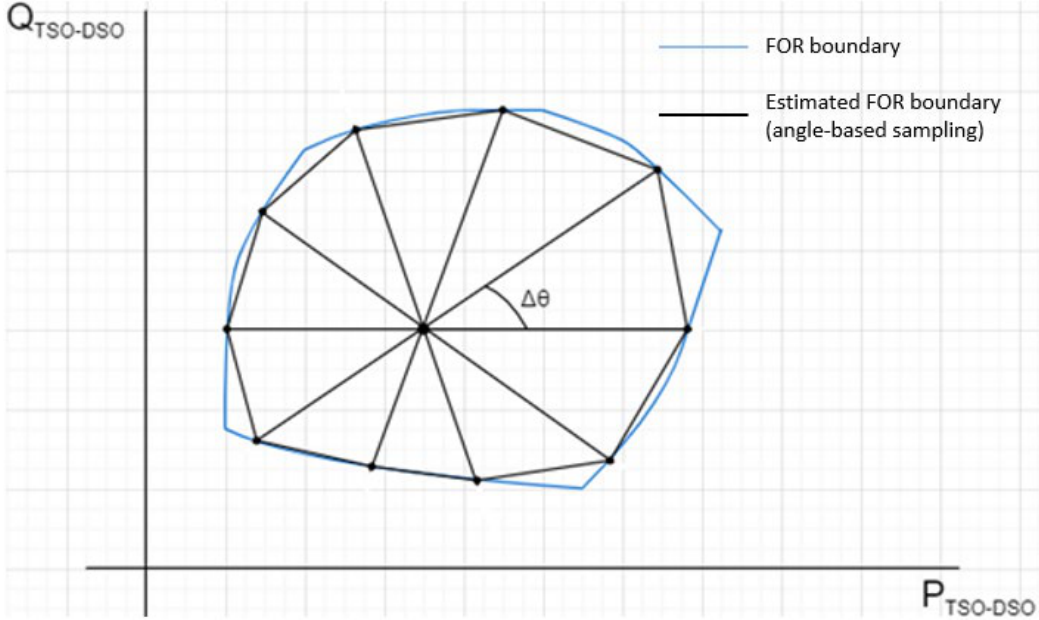
Figure 7. Visualization of angle-based sampling.